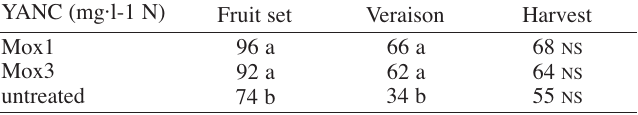
Table 2 - Yeast assimilable nitrogen content (YANC)